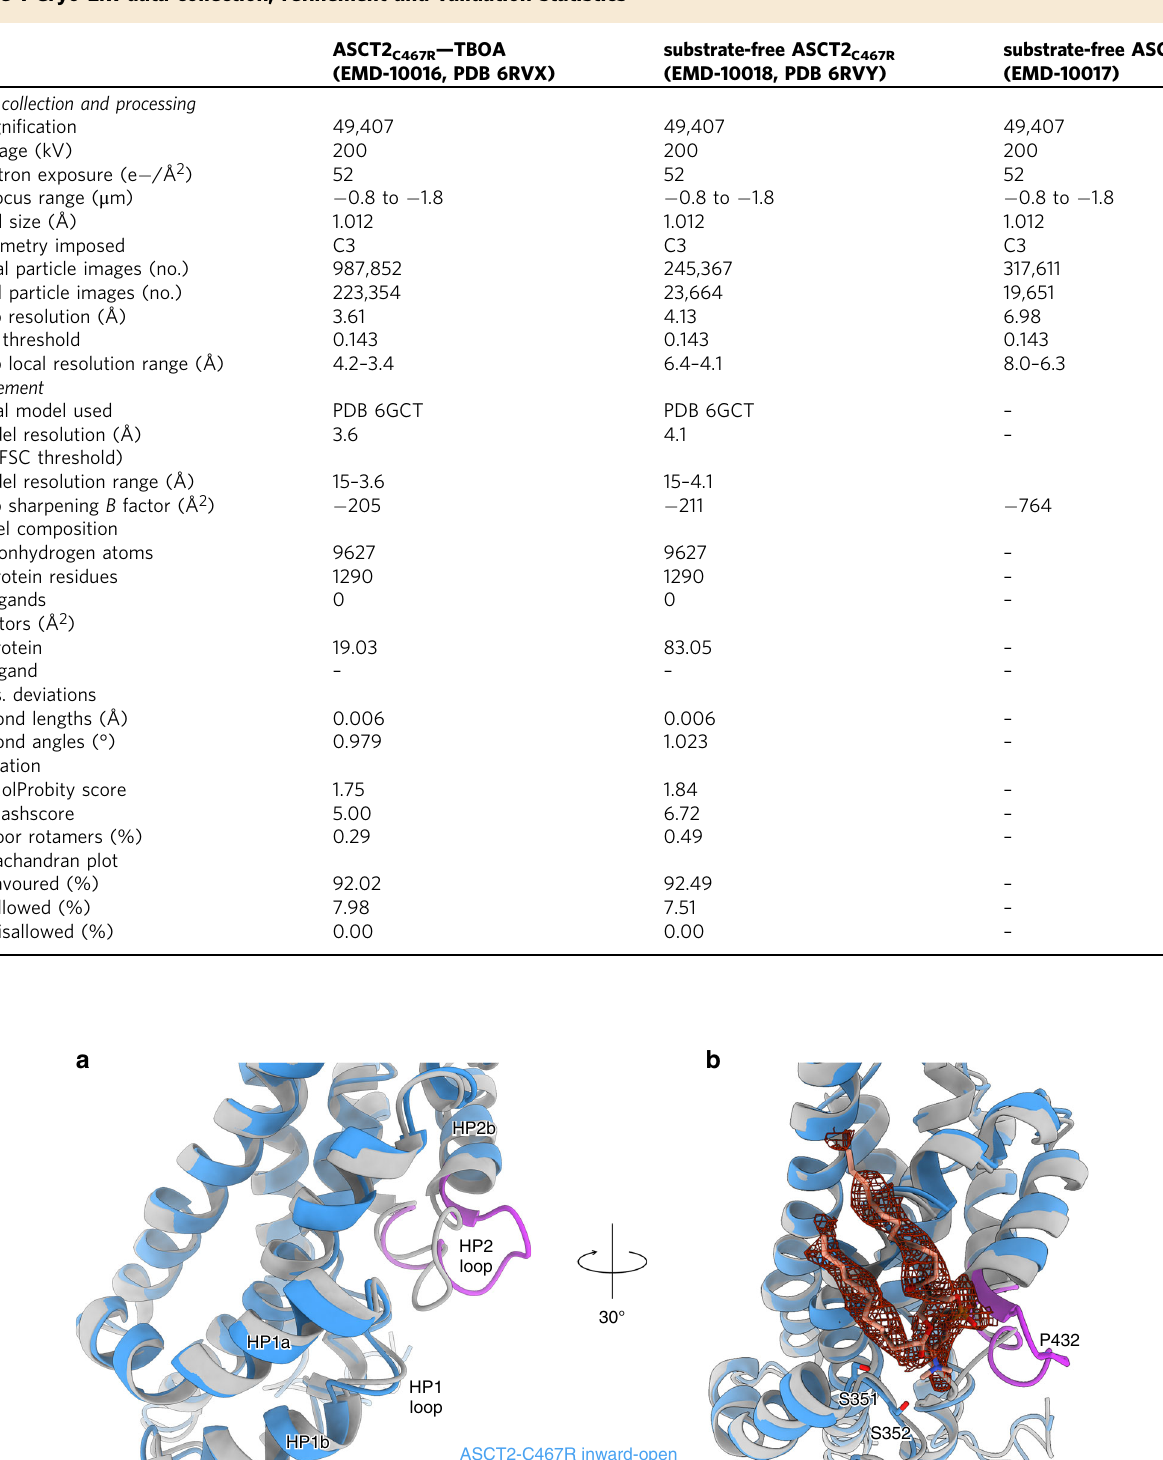
Table 1 Cryo-EM data collection, re fi nement and validation statistics